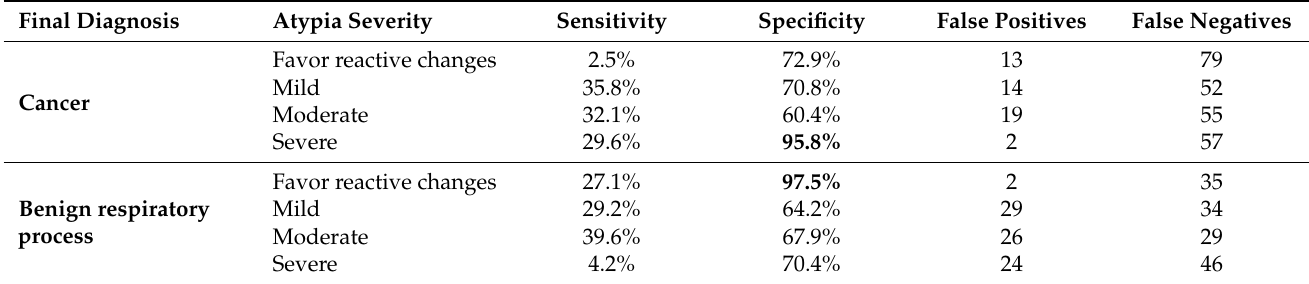
Table 2. Sensitivity and specificity of atypia severity on the outcome of final diagnosis.